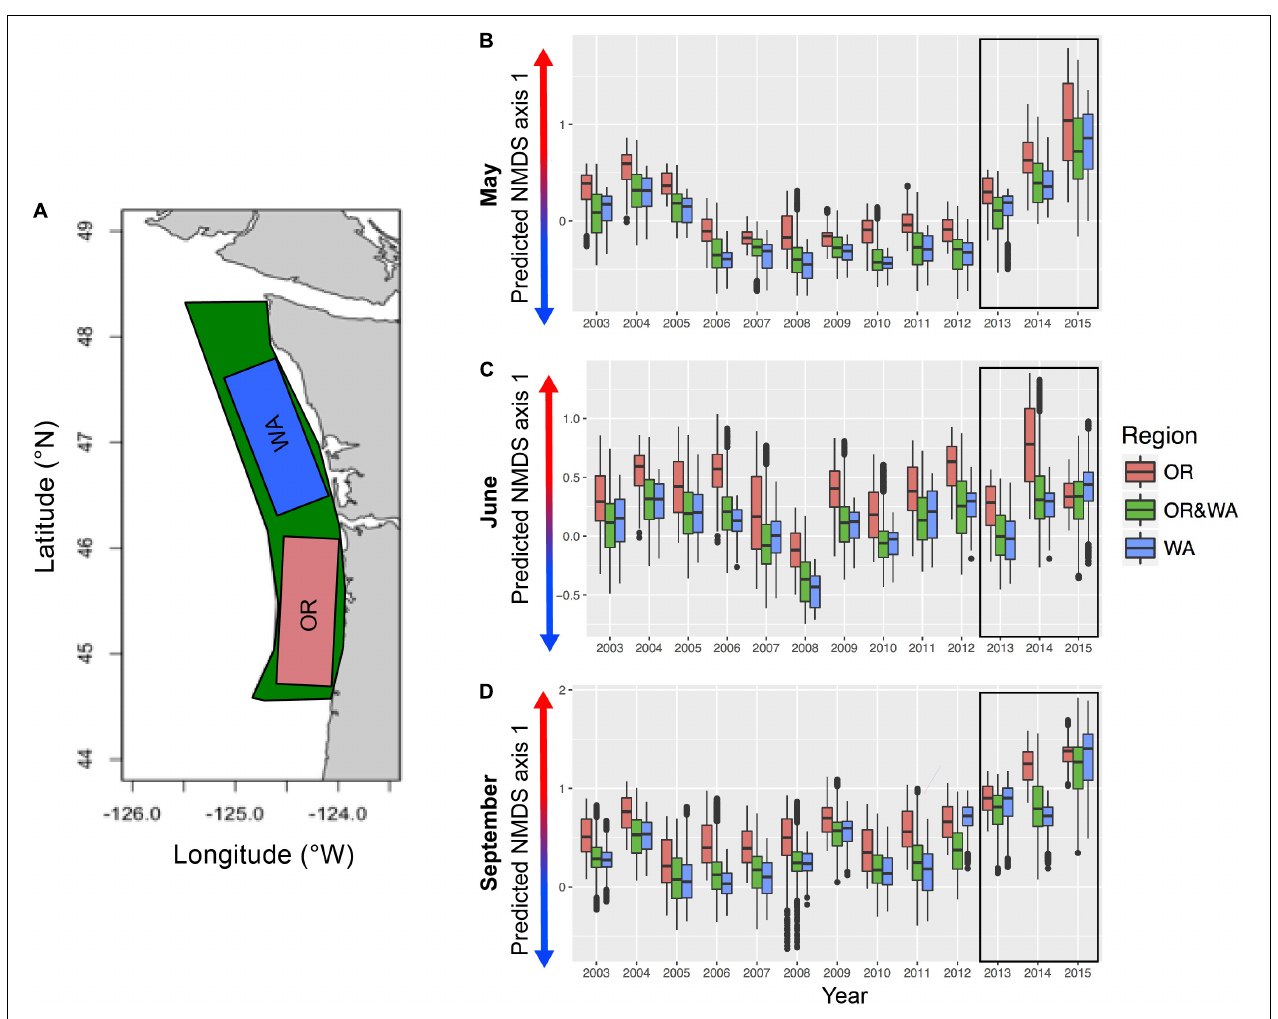
FIGURE 7 | Epipelagic community seascape index. Boxplots of the warm to cold community composition gradient (values plotted in boxplots are NMDS axis 1 scores) in each region [ (A) entire area sampled (green), OR (pink) and WA (blue)] during the month of (B) May, (C) June, (D) September. Higher values of NMDS axis 1 represent greater presence of warm community (warmer colors on arrows), lower values of NMDS axis 1 represent greater presence of cold community (cooler colors on arrows). Black box surrounding years 2013–2015 encompasses month/years where predictions were made outside of the range of the data included in the